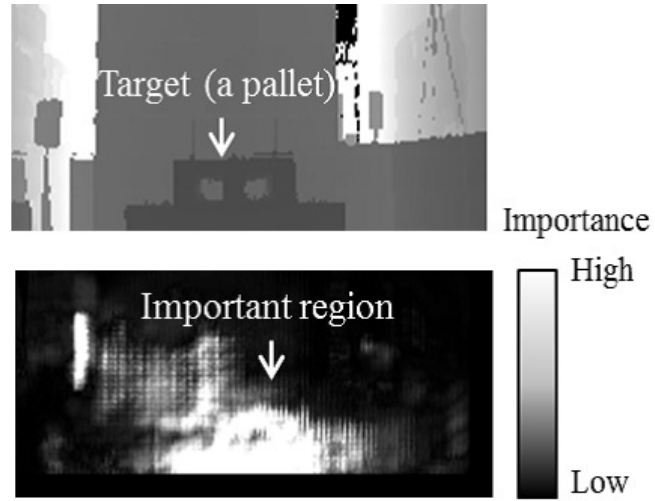
Figure 6. Example of augmented data. Randomized square patch, p is augmented to the original input image x .